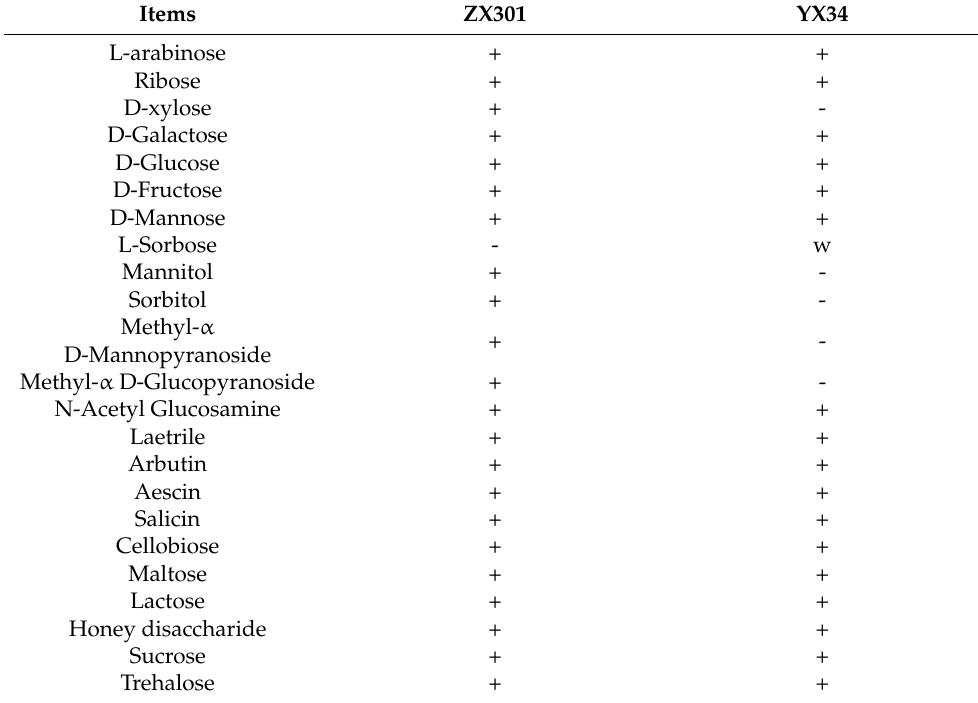
Table 2. The carbohydrate fermentation characteristics of isolated lactic acid bacteria